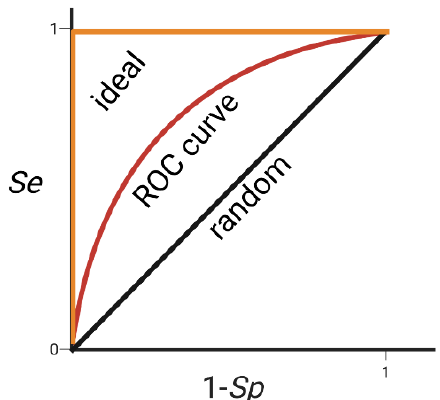
Figure 9. An example of Receiver operative characteristic (ROC) curve. Black: random classifier; orange: ideal curve; red: ROC curve.